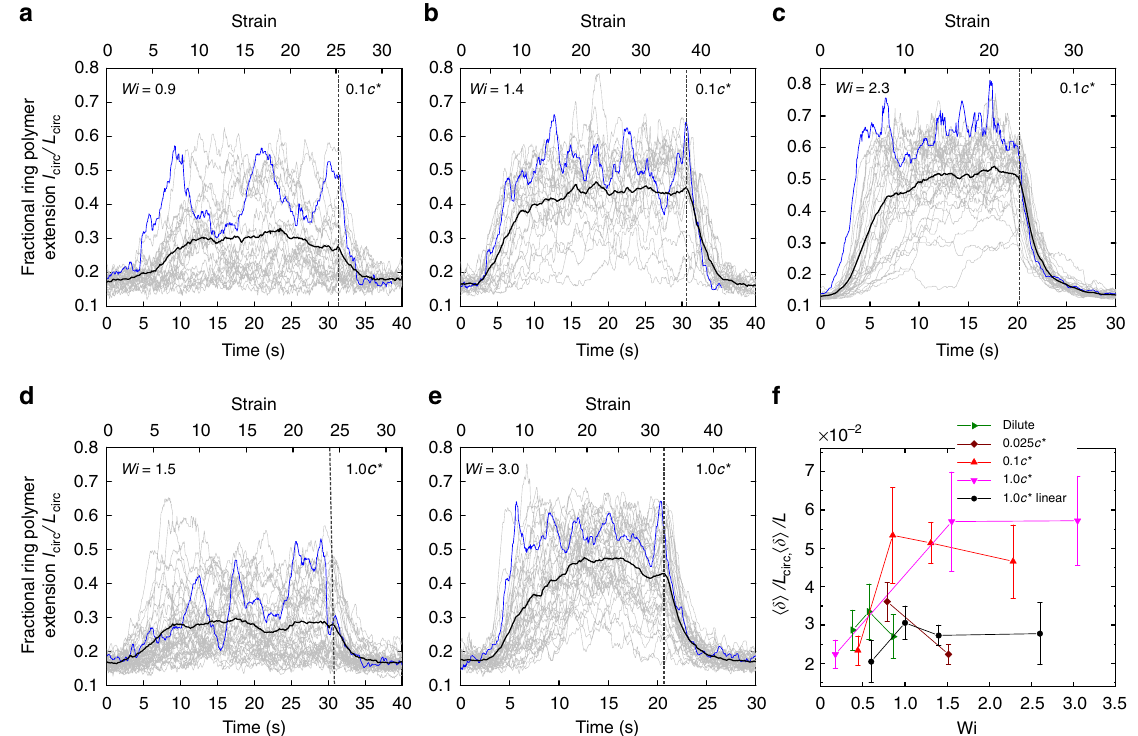
Fig. 3 Single molecule trajectories of ring polymers show large conformational fl uctuations. Transient fractional extension of ring DNA polymers in semidilute unentangled linear solutions with concentrations of 0.1 c * at a Wi = 0.9, b Wi = 1.4, and c Wi = 2.3, and background linear chain concentration of 1.0 c * at d Wi = 1.5, and e ) Wi = 3.0. Individual single molecule trajectories are shown in gray lines and ensemble averaged trajectories are shown in a black line. A characteristic individual single molecule trajectory is highlighted in blue line. Molecular ensembles consist of n = 24, n = 25, and n = 33 molecules, respectively for Wi = 0.9, 1.4, and 2.3 at 0.1 c * , and n = 38 for both Wi = 1.5 and Wi = 3.0 at 1.0 c * . The dashed line indicates the time at which the step strain input is stopped. f Magnitude of ring polymer conformational fl uctuations as a function of Wi , plotted as average fractional fl uctuation values, such that average chain extension fl uctuations 〈 δ 〉 are normalized by the contour length of ring polymers L circ and linear polymers L , respectively. Data for ring polymers in dilute solution, 0.025 c * linear semidilute solution, 0.1 c * linear semidilute solution, and 1.0 c * linear semidilute solution are denoted as dark cyan right triangle, dark red diamond, red up triangle, and magenta down triangle, respectively. Data for 1.0 c * linear polymers (black circle) are taken from prior work 33 . Error bars represent standard deviation. Source Data are provided as a Source Data fi